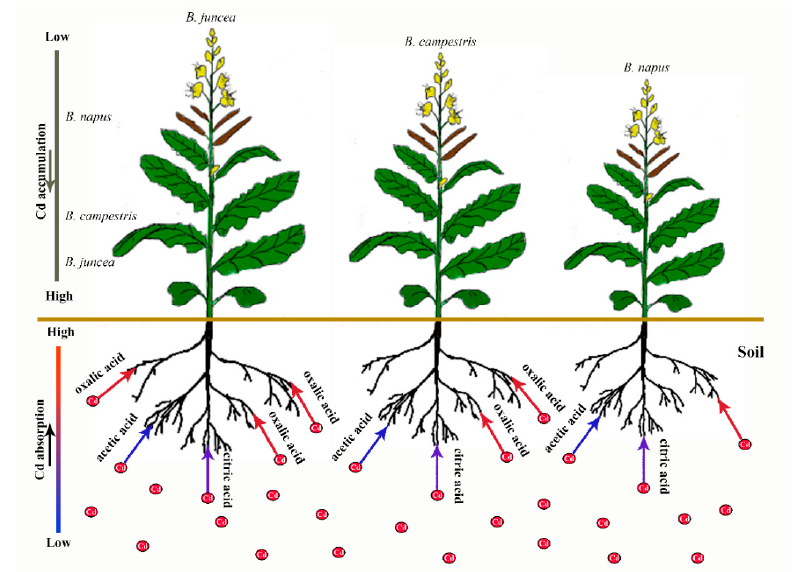
Figure 7. Pattern diagram of Cd phytoremediation by -utilizing Brassica juncea and oxalic acid. Arrows of different colors indicate the strength of Cd absorption mediated by organic acids.